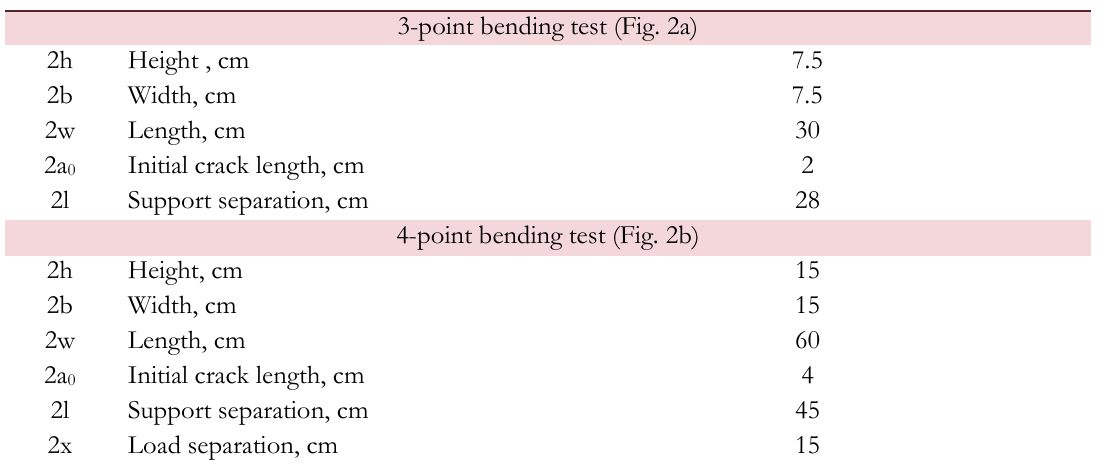
Table 2: Geometrical parameters of the specimen.